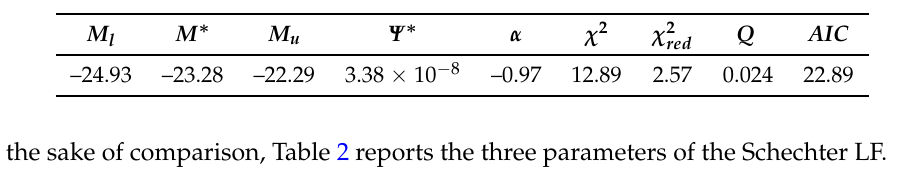
Figure 4. The observed LF for QSOs, empty stars with error bar, and the fit by the truncated Schechter LF when z [ 0.3,0.5 ] and M [ − 24.93, − 22 ] . Table 1. Parameters of the truncated Schechter LF in the range of redshifts [ 0.3,0.5 ] when n = 10 and k = 5.